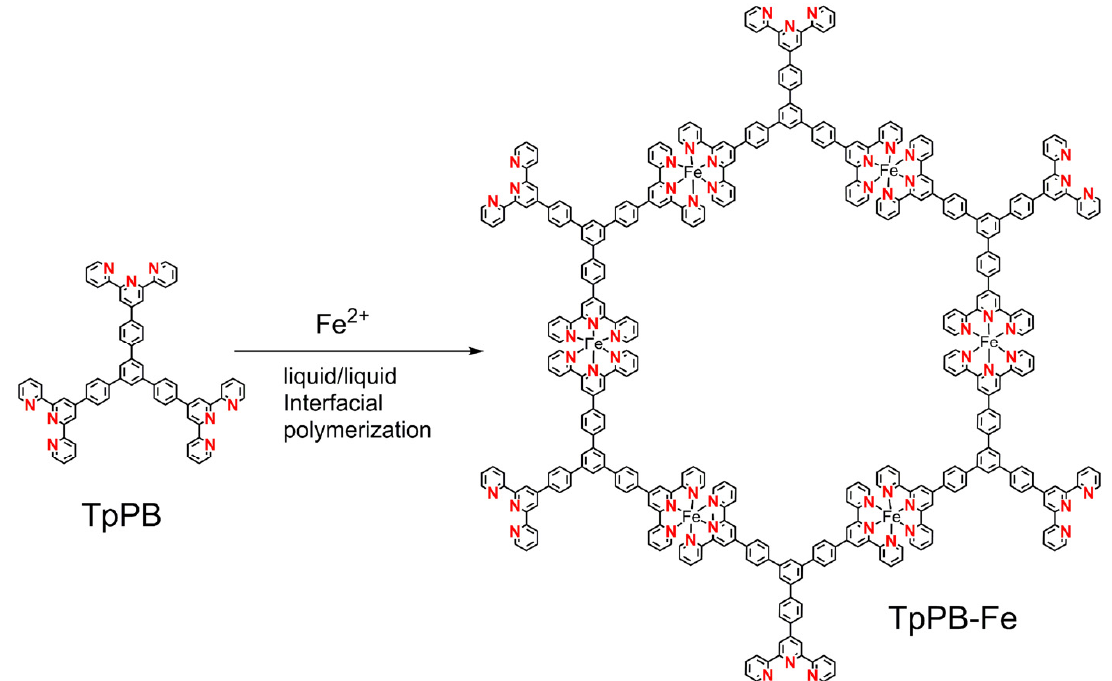
Figure 1. The structure of TpPB-Fe coordination polymer.